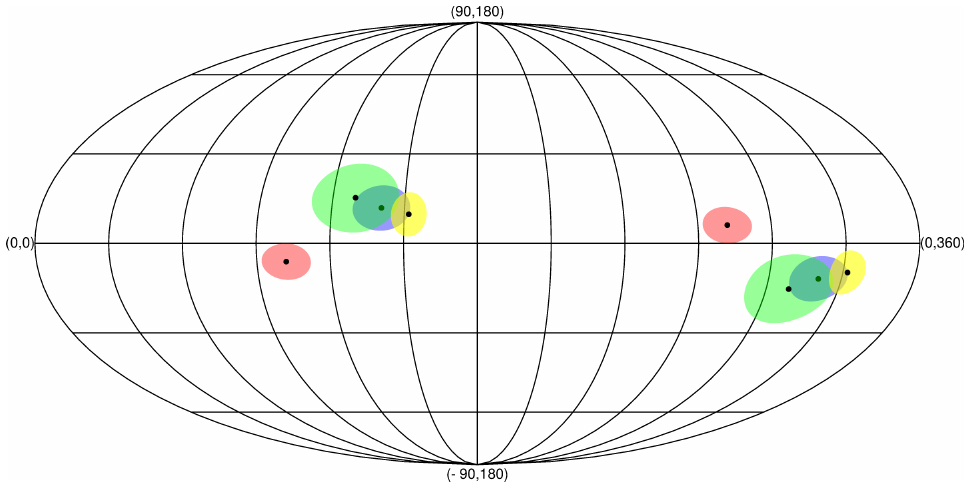
Figure 1. Directions in galactic coordinates for the α (blue) and Dark Energy (green) dipoles, for the Dark Flow direction (red) and for the direction of Maximum Temperature Asymmetry (MTA) in the 7 years ILC CMB map degraded to N opposite corresponding directions are also shown (from